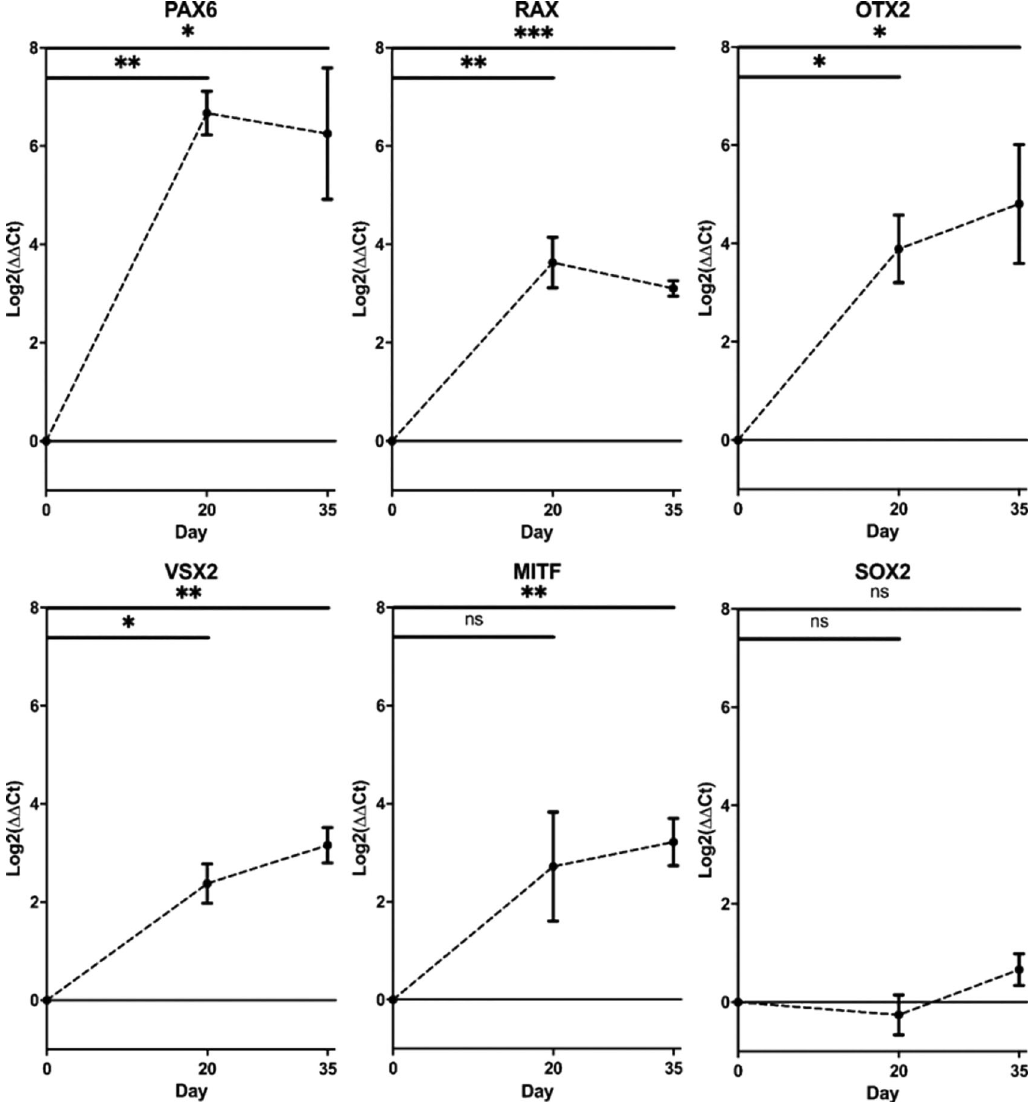
Figure 3. Changes in gene expression of early eye development transcription factors. PAX6, RAX, OTX2, VSX2, MITF and SOX2 transcript levels in optic vesicles at day 0, day 20 and day 35. Transcript levels were measured using RT-qPCR and presented as a log 2 fold change in expression from undifferentiated cells at day 0. Expression levels normalised to housekeeping gene glyceraldehyde 3-phosphate dehydrogenase (GAPDH). (* p <0.05, ** p <0.01, *** p <0.001). Error bars represent the standard deviation between replicates